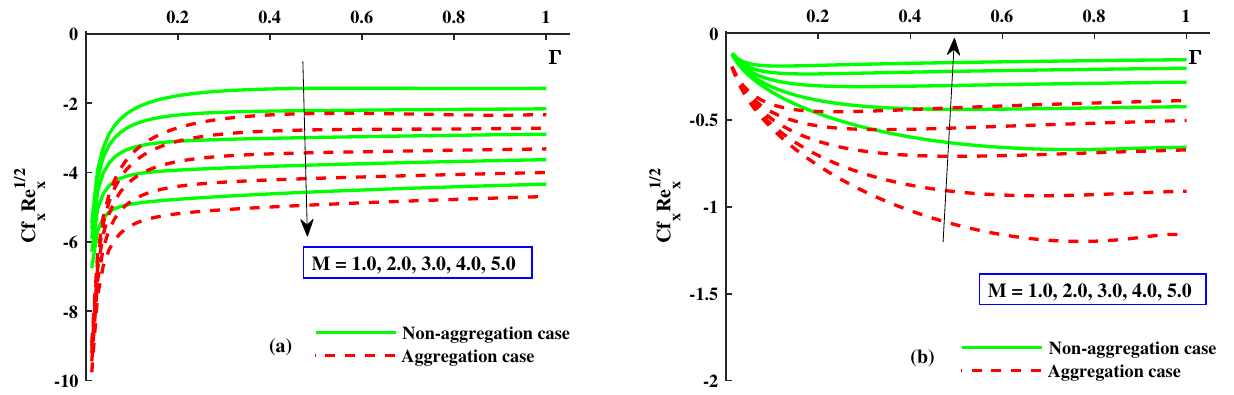
1 / 2 x in x-direction, and Cf y Re